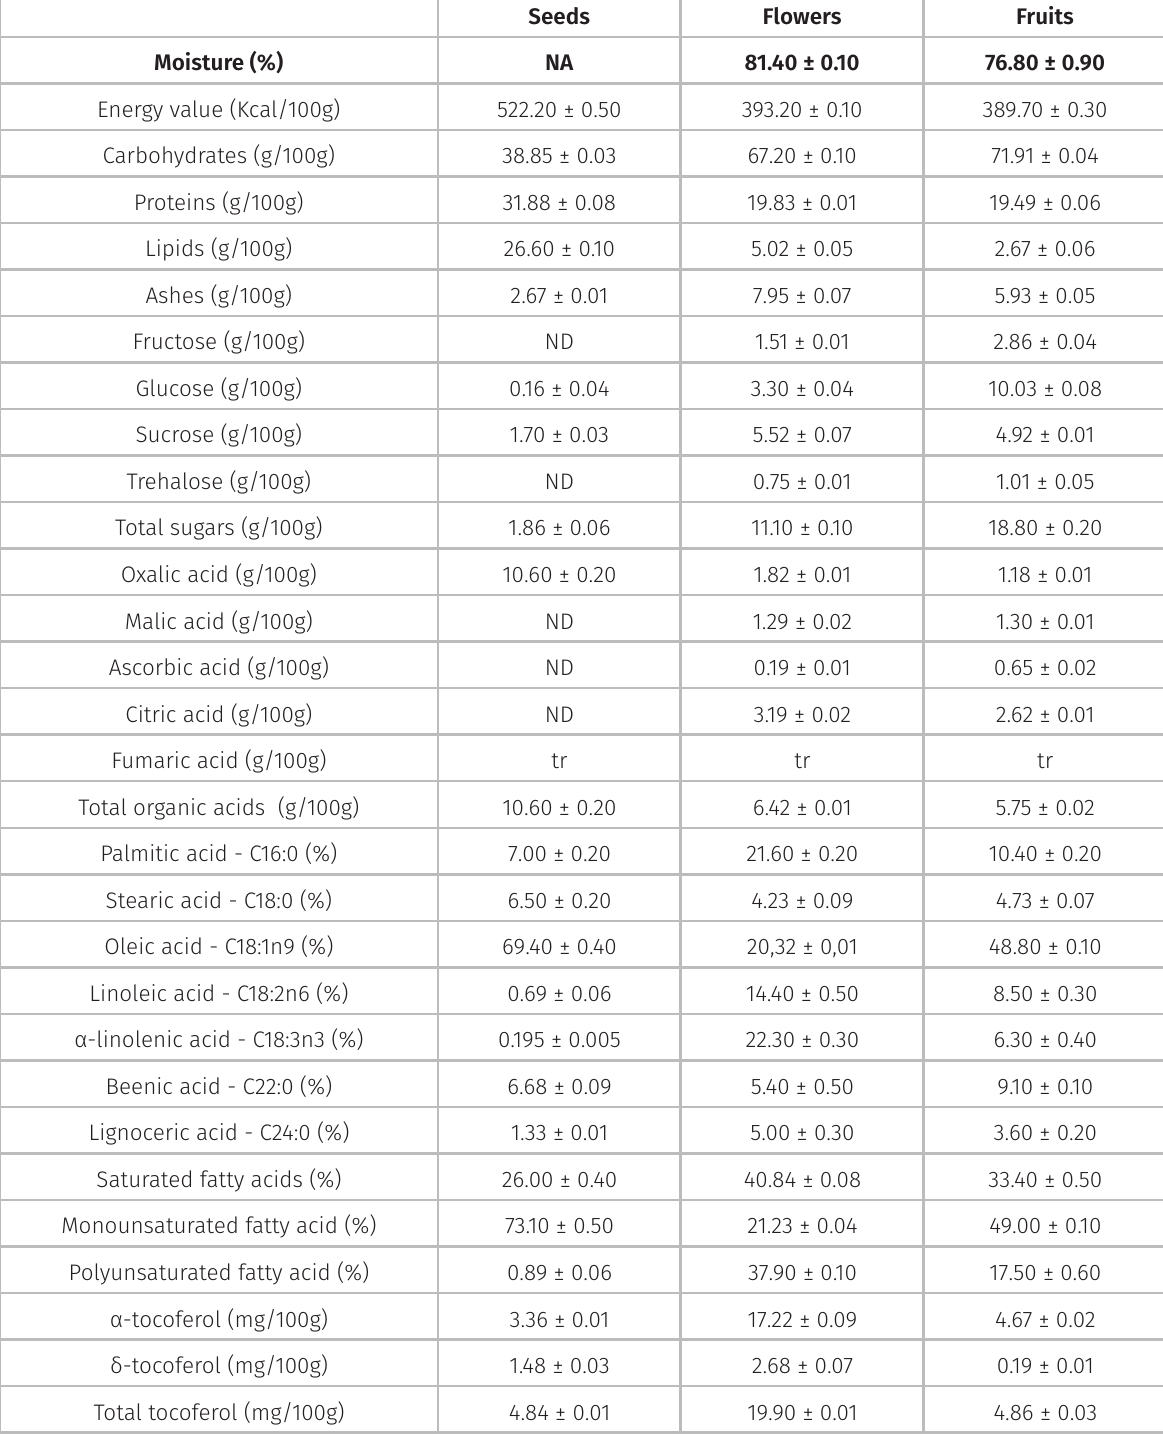
Table I. Nutritional value and composition of Moringa oleifera seeds, flowers and fruits a . Seeds